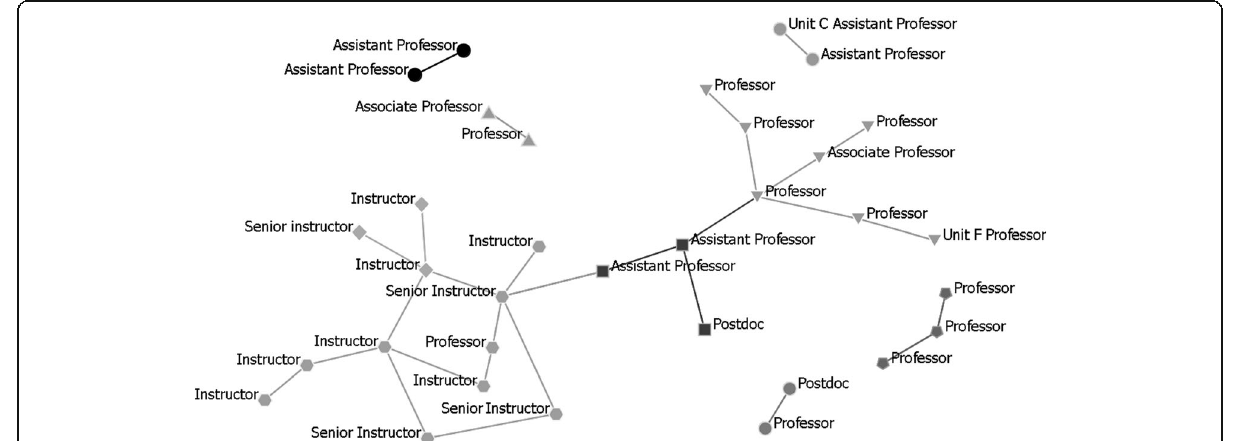
Fig. 3 Subgroups of unit D denoted by shape and color of nodes and